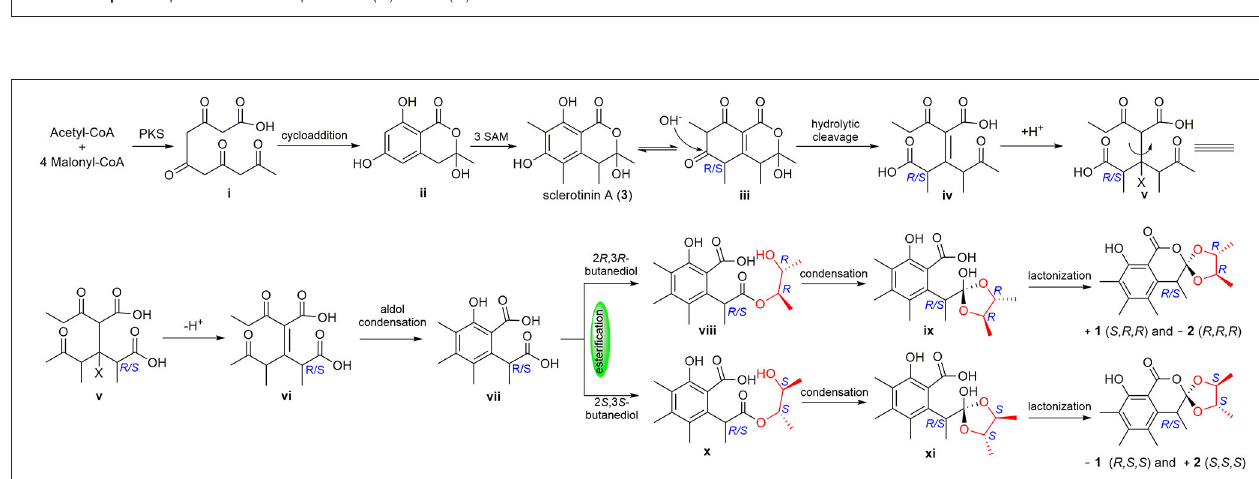
FIGURE 5 | The experimental ECD spectra of ( ± )- 1 and ( ± )- 2 and the cal-culated ECD curves.